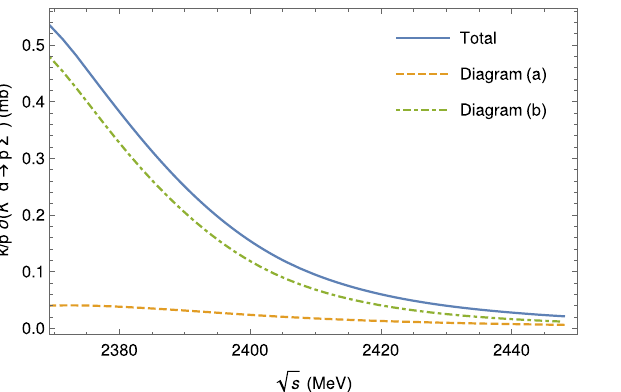
σ using the θ function or the deuteron wave p